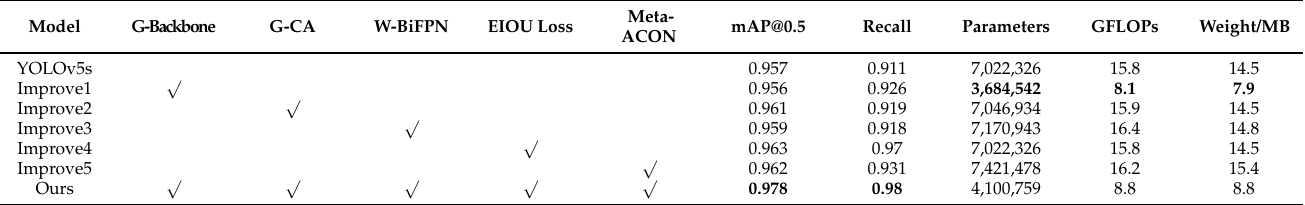
Table 6. Ablation